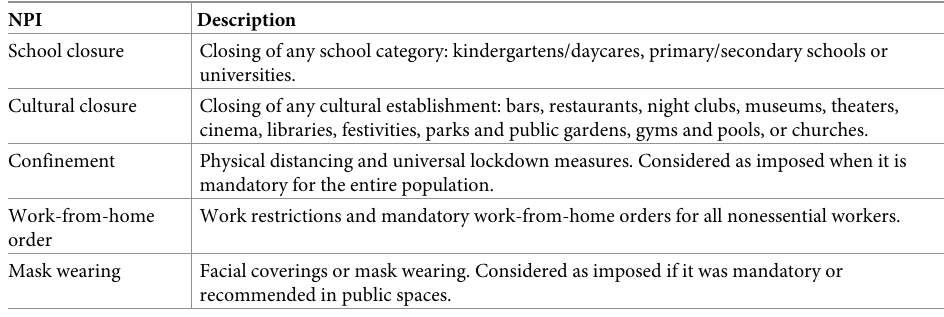
Table 1. Description of the five NPIs used in this